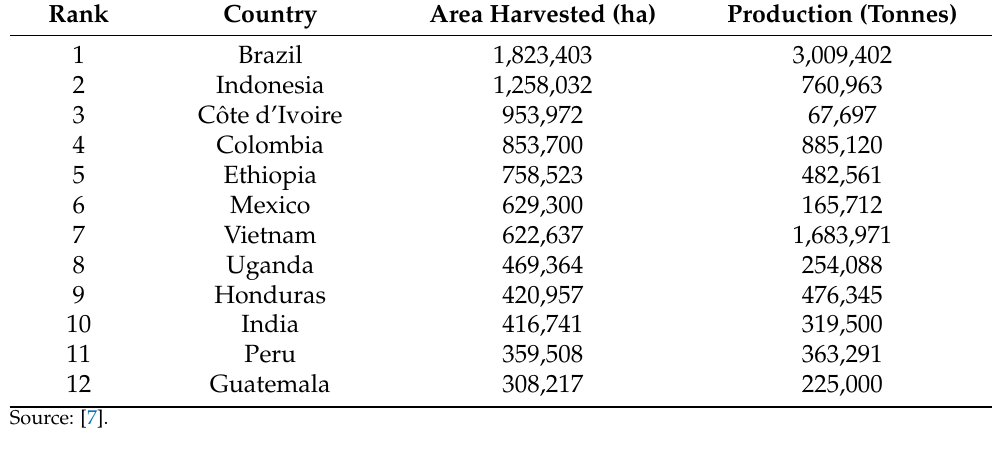
Table 1. Top-producing countries in the world in 2019. Rank Country Area Harvested (ha) Production (Tonnes)